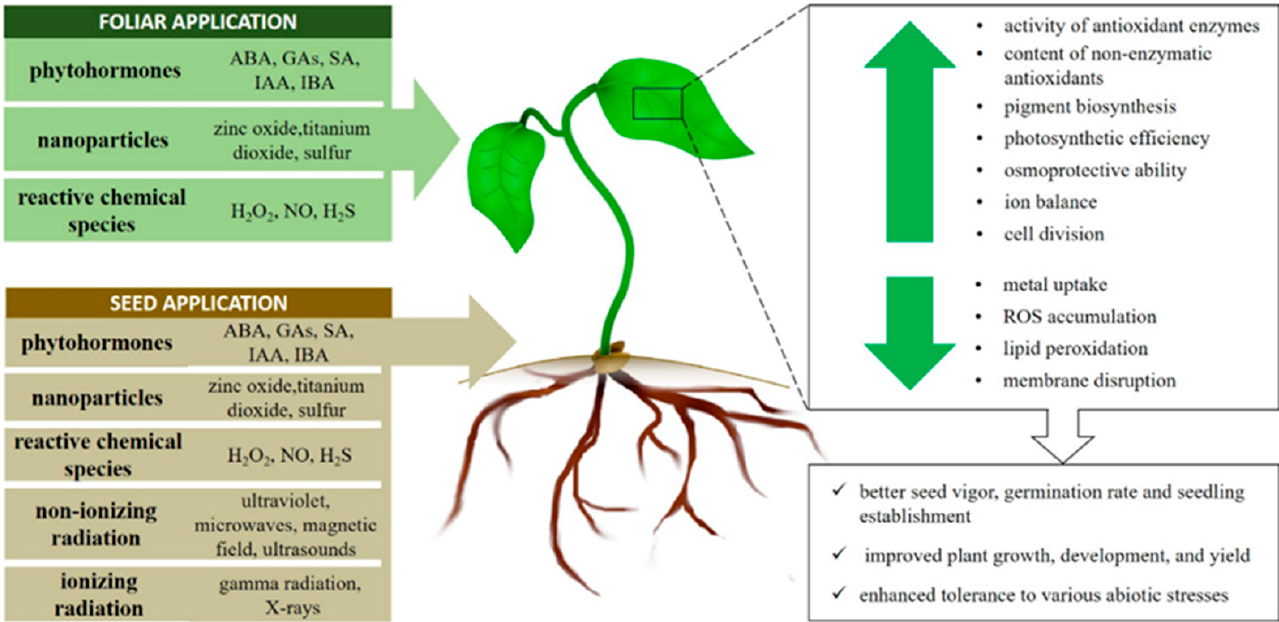
Figure 2. Types of exogenously applied priming agents discussed in this review, as well as their possible applications and the beneficial consequences of treatments that protect plant cells and provide improved defense potential.